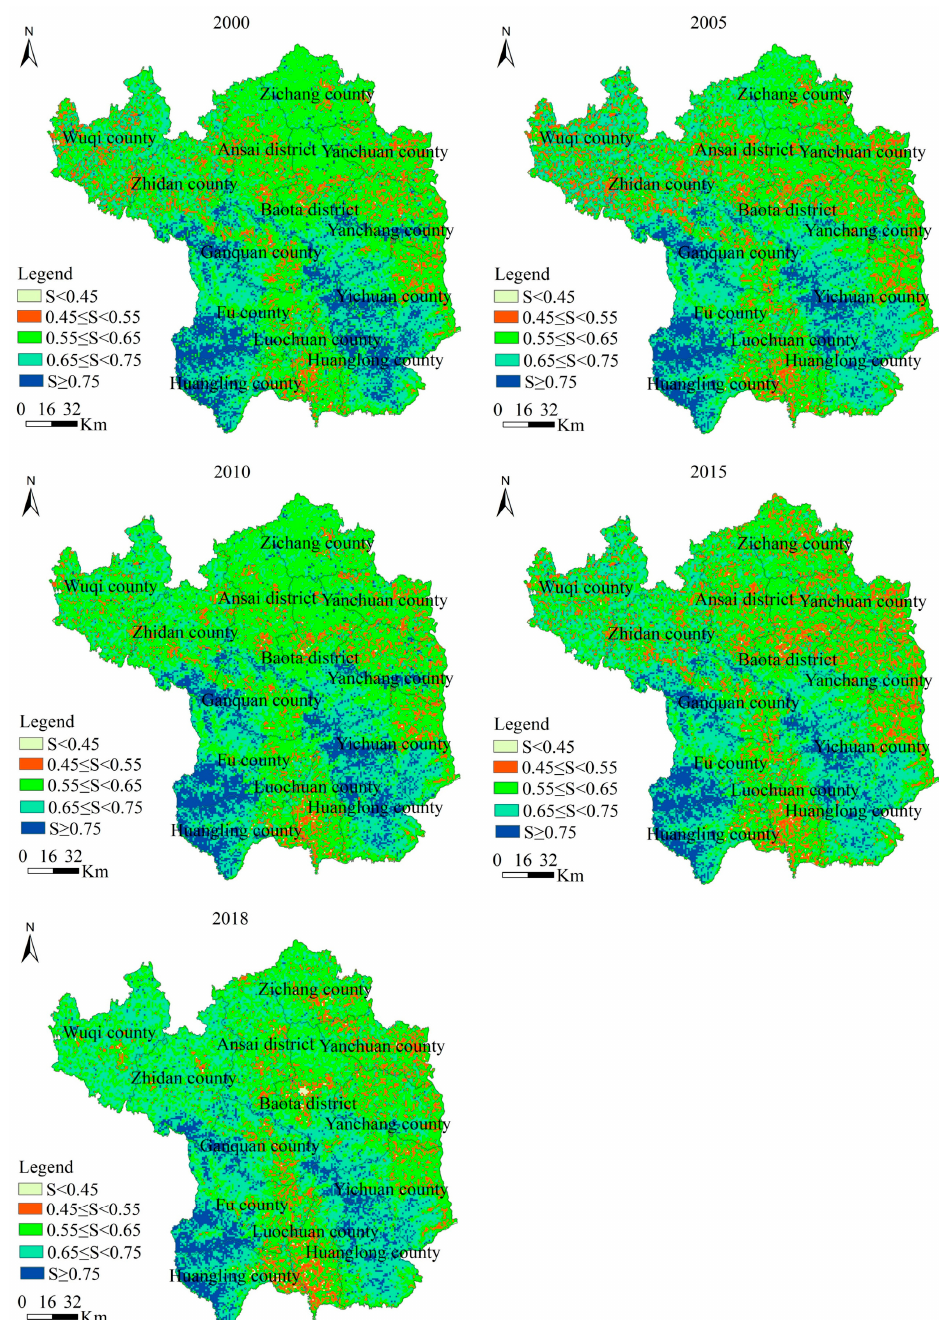
Figure 2. Spatiotemporal pattern of land ecological security (LES) in Yan’an. S represents the ecological security index measuring LES level. S ≥ 0.75 represents the high level, 0.65 ≤ S < 0.75 represents the medium − high level, 0.55 ≤ S < 0.65 represents the medium level, 0.45 ≤ S < 0.55 represents the medium − low level, and S < 0.45 represents the low level.